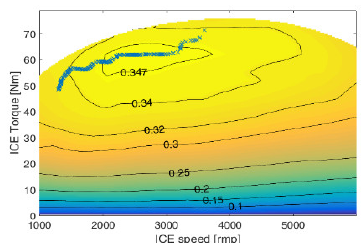
Figure 28. Series architecture: ICE working points.